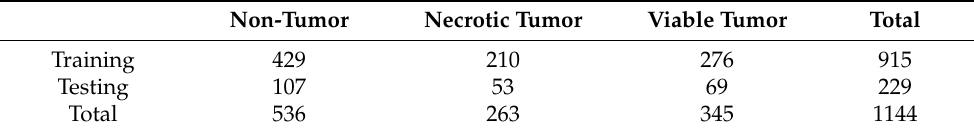
Figure 15. ROC curves of MobileNet-V3-Small with different losses on the osteosarcoma histology image dataset. 0 0.20.4 0.60.8 1 0